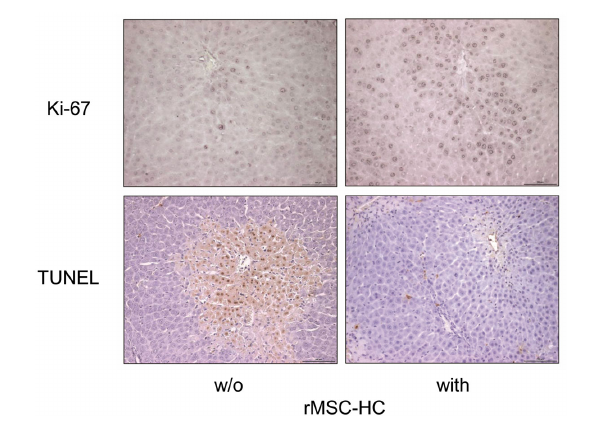
FIGURE 4 |Anti-apoptotic and pro-proliferative action of MSC after acetaminophen intoxication of the rat liver. Rats were treated with a repeated dose of 4g/kg body weight of acetaminophen. Eighteen hours after the last dose the animals were sacrificed and the livers prepared for the detection of apoptotic cells (dark nuclei) by theTUNEL assay (lower panels) or proliferating cells (dark nuclei) by the Ki67 stain (upper panels). Where indicated animals received adipose tissue-derived rat MSC pre-differentiated into hepatocyte-like cells (rMSC-HC) 6h after the last dose of acetaminophen. It is obvious that the number of apoptotic cells was significantly lower but of proliferating cells was higher in the livers with MSC (right panels) indicating the anti-apoptotic and pro-proliferative action of the